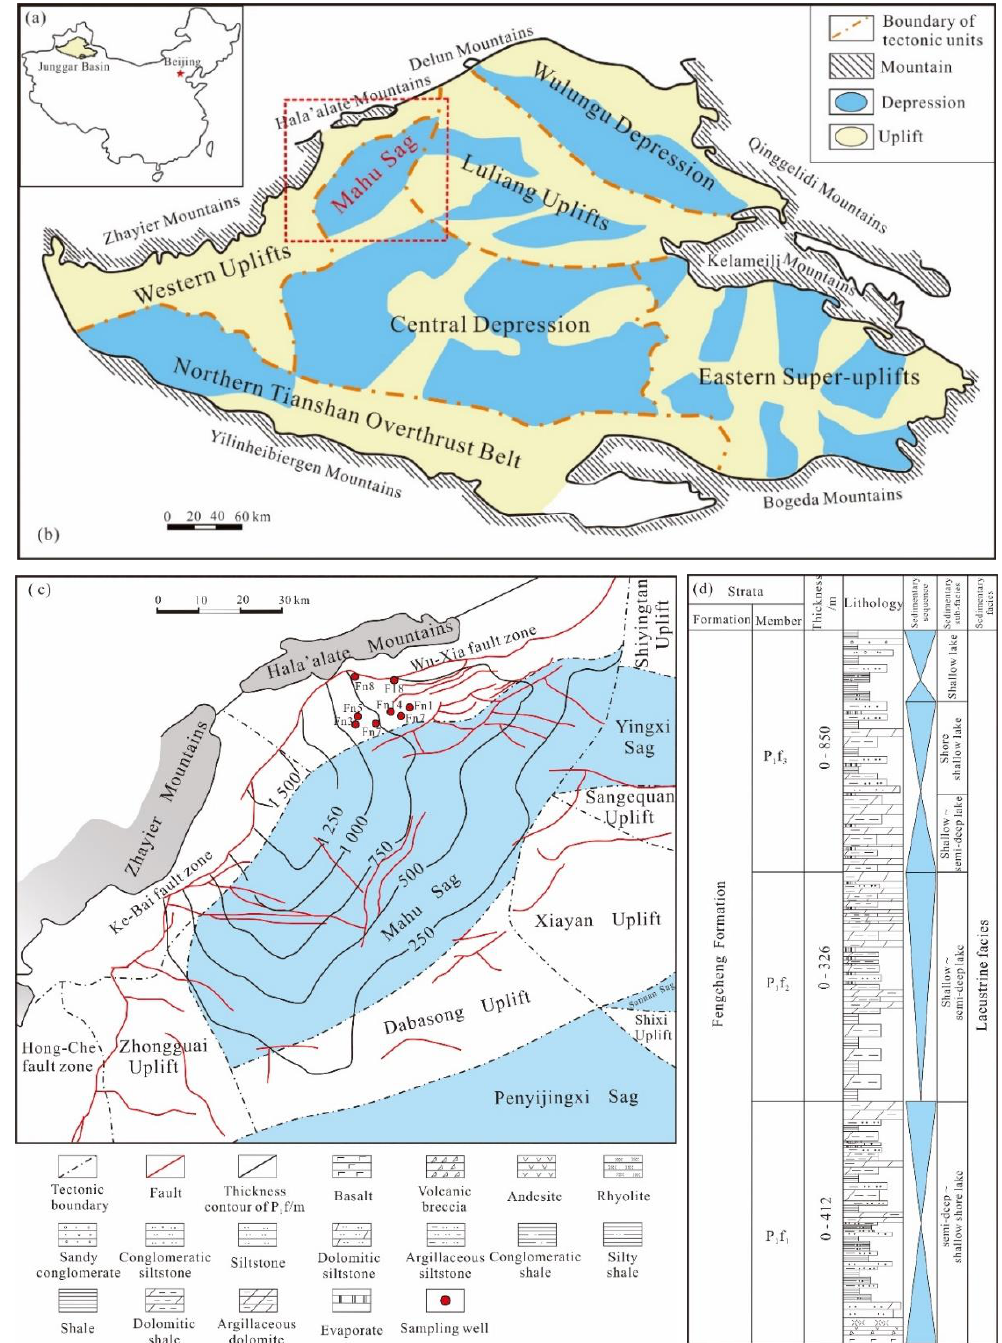
Figure 1. ( a ) Map of the Junggar Basin in China. ( b ) The division of tectonic units in the Junggar Basin and the location of the Mahu scheme. ( c ) The division of sub-tectonic units and thickness contour of Fengcheng Formation in Mahu Sag. ( d ) Lithology and sedimentary facies profile of the Fengcheng Formation in the Mahu Sag, modified after [22].